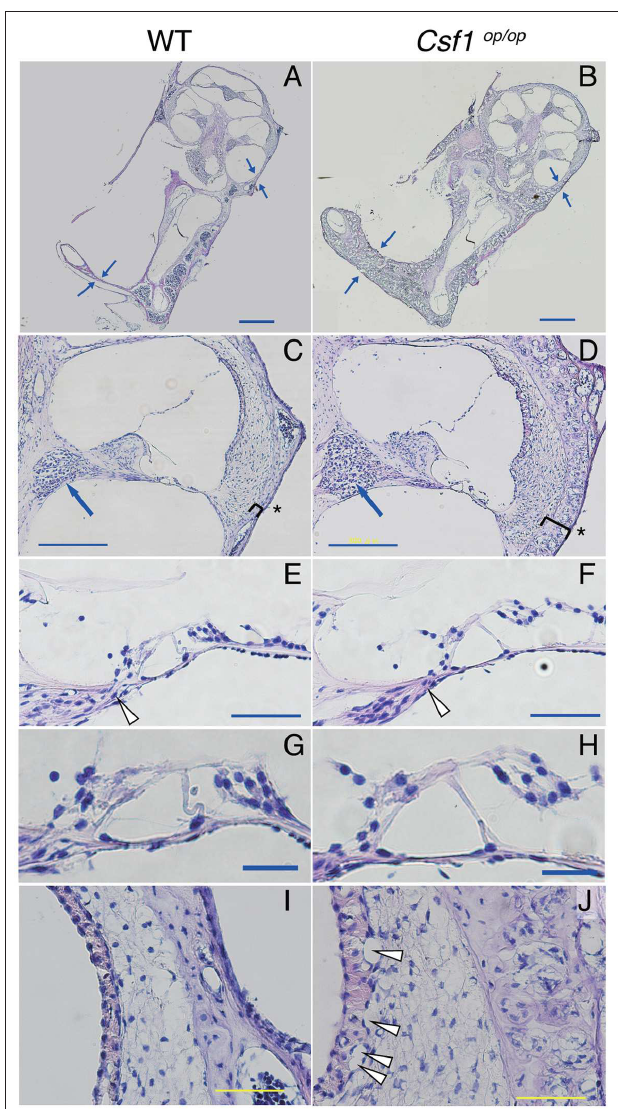
FIGURE 2 | Histological analyses demonstrated that the otic capsules of Csf1 op / op mice have bone thickening and spongy bone degeneration. (A,B) Irregular lesions in Csf1 op / op mice cause bone thickening of the otic capsule with spongy bone degeneration (arrows). Despite thickening of the otic capsule (parentheses), the spiral ganglion (arrows in C,D ), the habenula perforata (arrowheads in E,F ), and the organ of Corti (G,H) appear normal because at least one row of IHC, three rows of OHCs, and the triangle formed by two pillar cells appear to be preserved, whereas vacuolar formation in the basal cell layer of the stria vascularis was observed in Csf1 op / op mice (arrowheads in I,J ). The organ of Corti in the cochlear basal turn is shown. Bars: 500 µ m for (A,B) , 200 µ m for (C,D) , 50 µ m for (E,F,I,J) , 20 µ m for (G,H) .